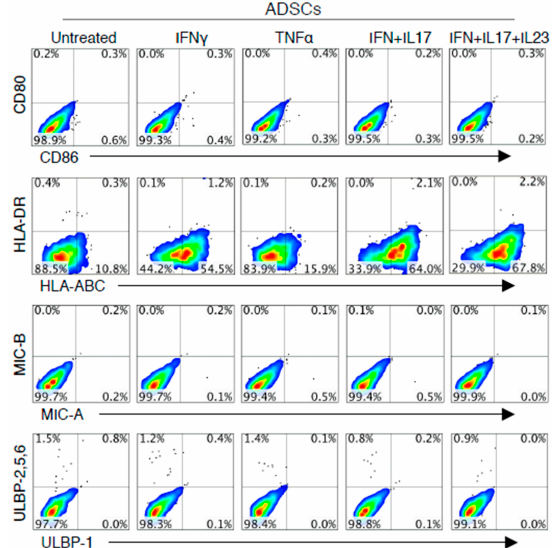
Figure 1. Effect of pro-inflammatory cytokines on the expression of human leukocyte antigens ( HLAs) and co-stimulatory molecules on the surface of ADSCs. ADSCs were isolated from human adipose tissue and cultured in complete Dulbecco’s modified Eagle’s medium (DMEM). ADSCs that had been passaged fewer than eight times were used. ADSCs were stained with monoclonal antibodies (mAbs) against CD80 and CD86. ADSCs were additionally stained with mAbs against HLA-DR and HLA- ABC and for markers of NKG2DL with mAbs against MIC-A, MIC-B, ULBP1 and ULBP2/5/6. The data are representative of at least three experiments. IFN+IL-17: combination of IFN- γ and IL-17A/F; IFN+IL-17+IL-23: combination of IFN- γ , IL-17A/F and IL-23.